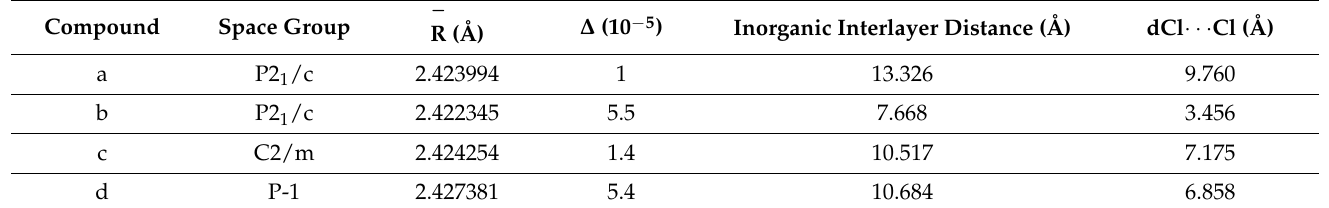
Table 2. Structure perovskite types with ∆ -values as a measure for distortion of the SnCl 6 octahedron. Compound